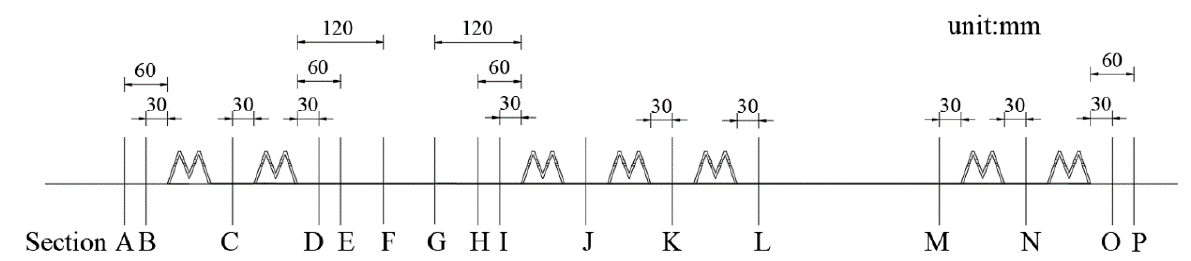
Figure 8. Cross-section distribution of artificial reefs.